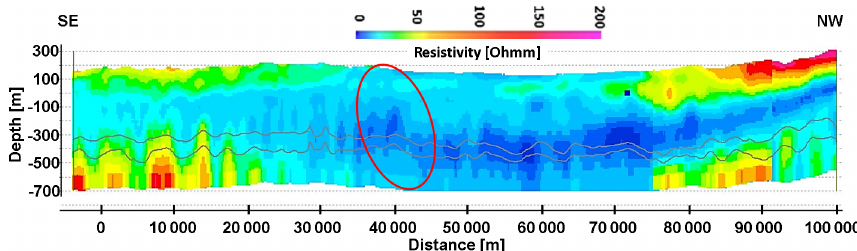
Figure 8. Cross section along NW–SE line 7 (Fig. 1a) showing faulting (within the red circle) in the Bimbila. The DOI is shown as a solid grey line (there are two of them according to their definition – more details on this distinction can be found in Christiansen and Auken, 2012).